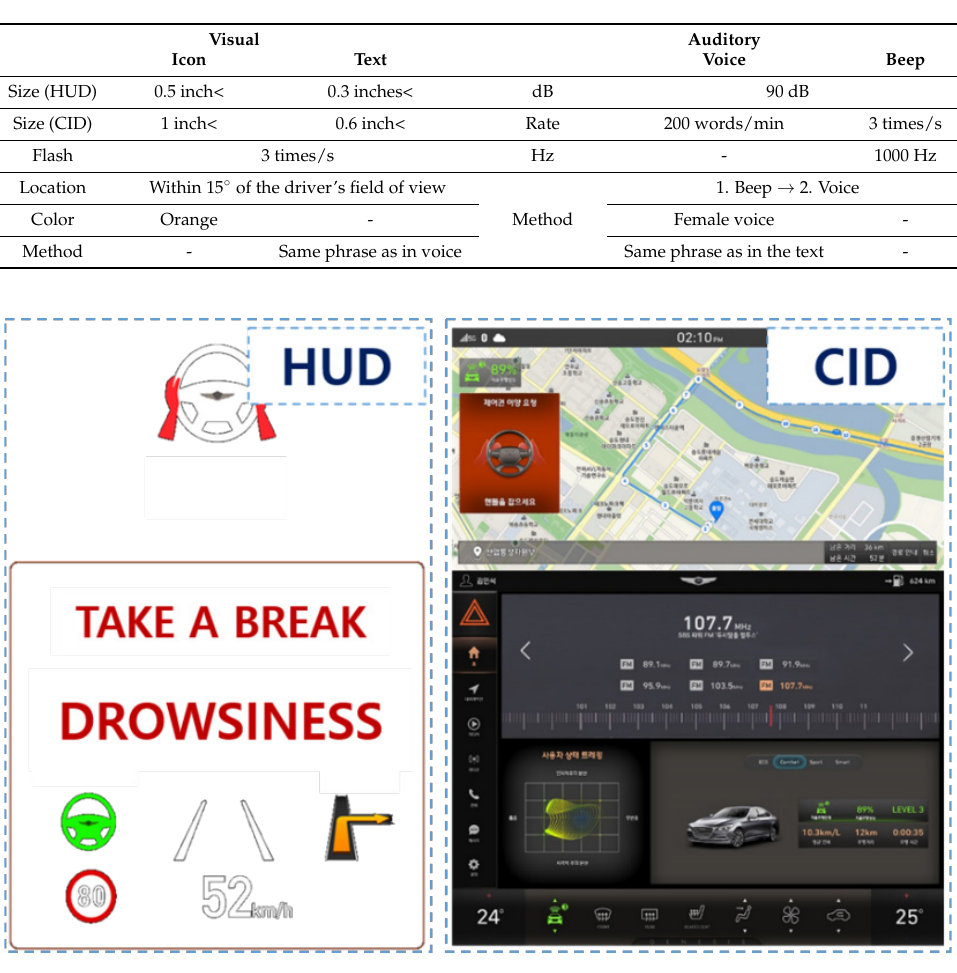
Figure 1. Example of the visual alarm design (HUD and CID).